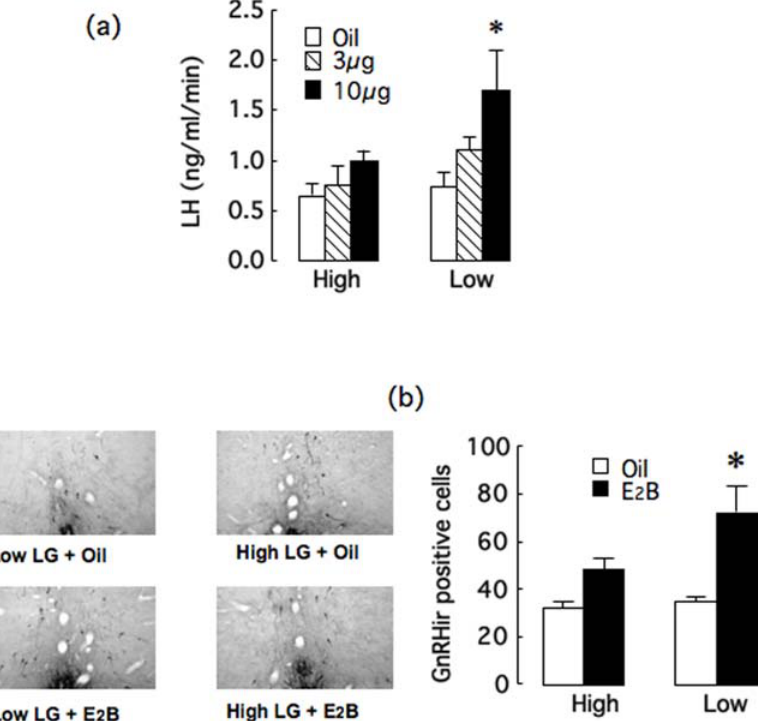
Figure 3. Estrogen effects on plasma LH and GnRH immunoreactive cells. (a) Mean 6 SEM plasma level of lutenizing hormone (LH) in ovariectomized adult female offspring of High or Low (n=5–7/group) provided with low-level E2B replacement and then treated acutely with 0, 3 or 10 m g of E2B 24h prior to sampling. Adult female offspring of Low LG mothers treated with 10 m g of E2B showed a greater level of LH than all other groups (* p , 0.05). (b) Photomicrograph of representative GnRH immunolabeling in the medial preoptic area of High or Low provided with low-level E2B replacement and then treated acutely with oil or 10 m g of E2B 24h prior to tissue sampling. The right panel reveals that the mean 6 SEM total number of GnRH-labeled cells located in the preoptic region (anteroventral preoptic nucleus, the median and lateral preoptic nucleus, the medial preoptic area) as well as the diagonal band nucleus in the Low offspring treated with E2B was greater than all other groups (n=5/group;* p , 0.05 ).